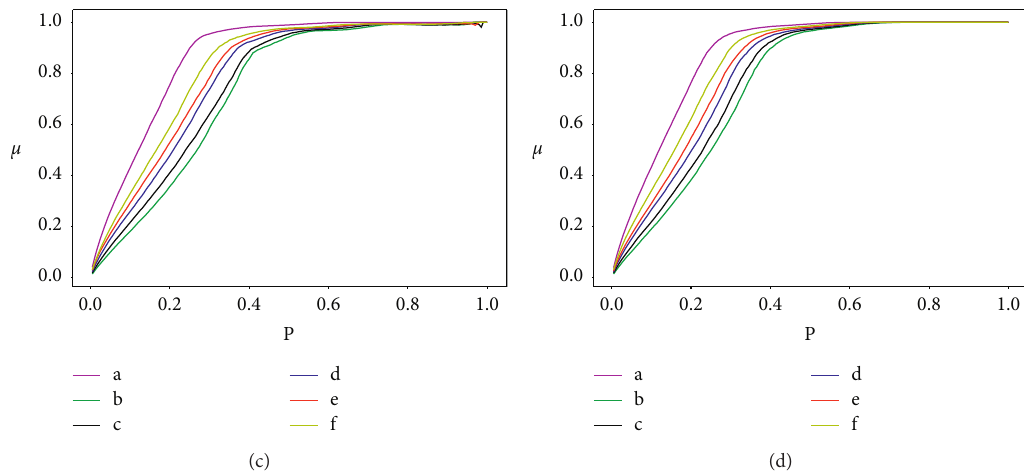
Figure 4: The change in network efficiency reduction rate μ after model A is attacked by different algorithms where N � 200, M � 3, curve A represents the BA network, and curve b–f represents the comparison of different parameters of model A (threshold � 0.1–0.5, change- s � 0.001). (a) deg, (b) SL, (c) LLS, and (d) LLSR.